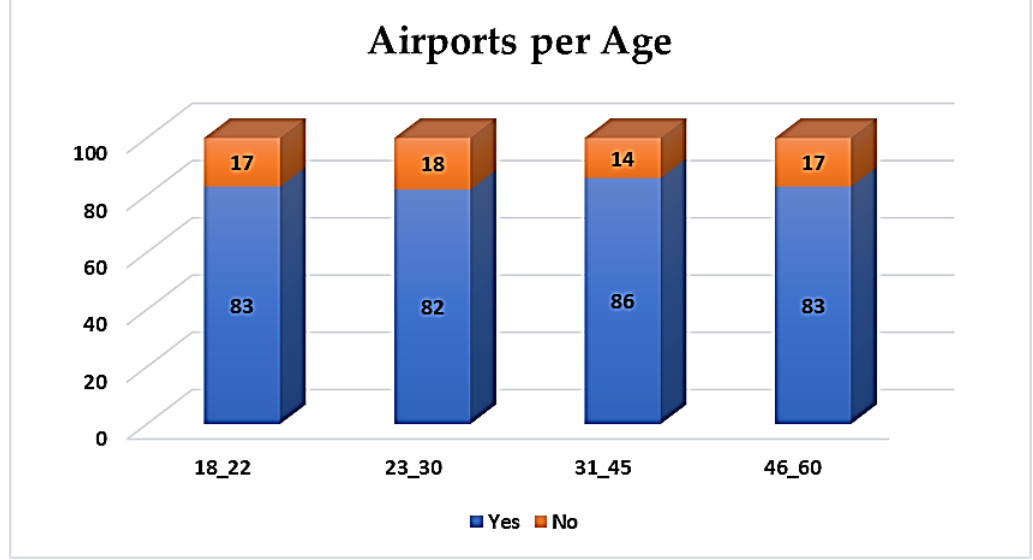
Figure 19. BS perceived integration to services—airport per age.